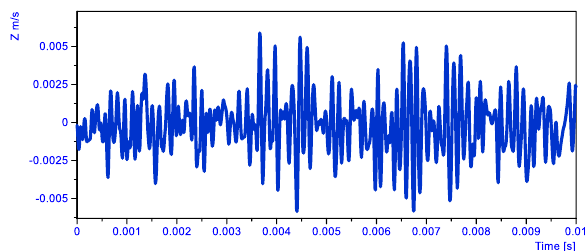
Fig. 9. The diagram of the vibration velocity in the Z axis; n = 3600 rpm, M =75 Nm, α wtr = 5°